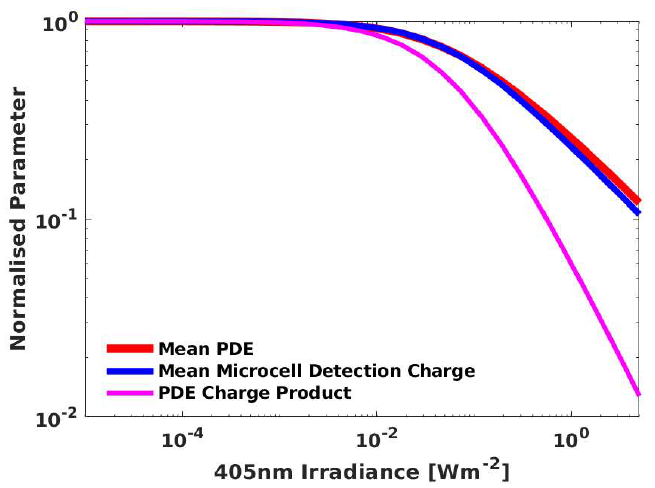
Figure 12. The mean array PDE when photons are detected and the mean charge on the microcells that have detected a photons. that have detected a